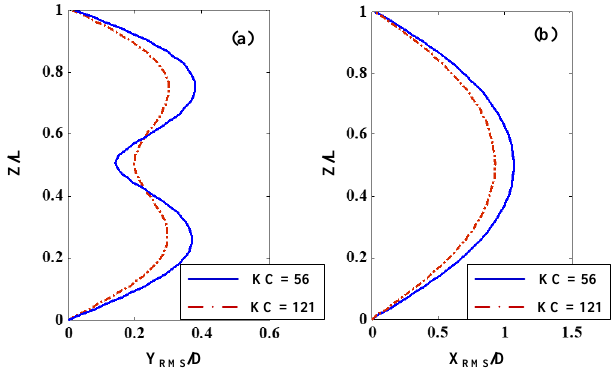
Figure 4. Distribution of displacement response along the flexible pipe in the CF and in-line (IL) directions for different KC numbers under V R2 = 5.2: ( a ) The VIV displacement response in the CF direction; ( b ) The VIV displacement response in the IL direction.